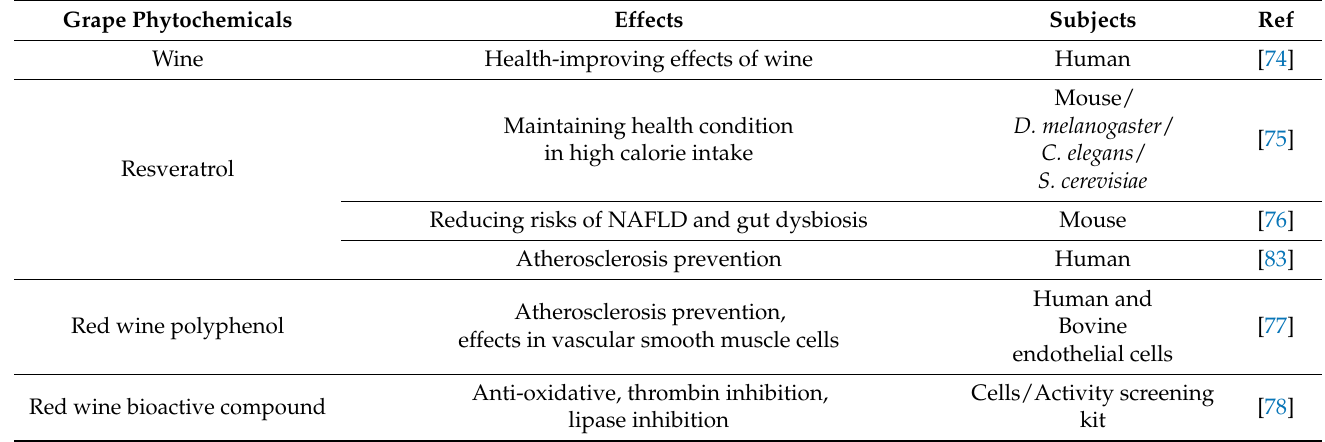
Table 2. Anti-metabolic syndrome and anti-inflammatory effects of grape